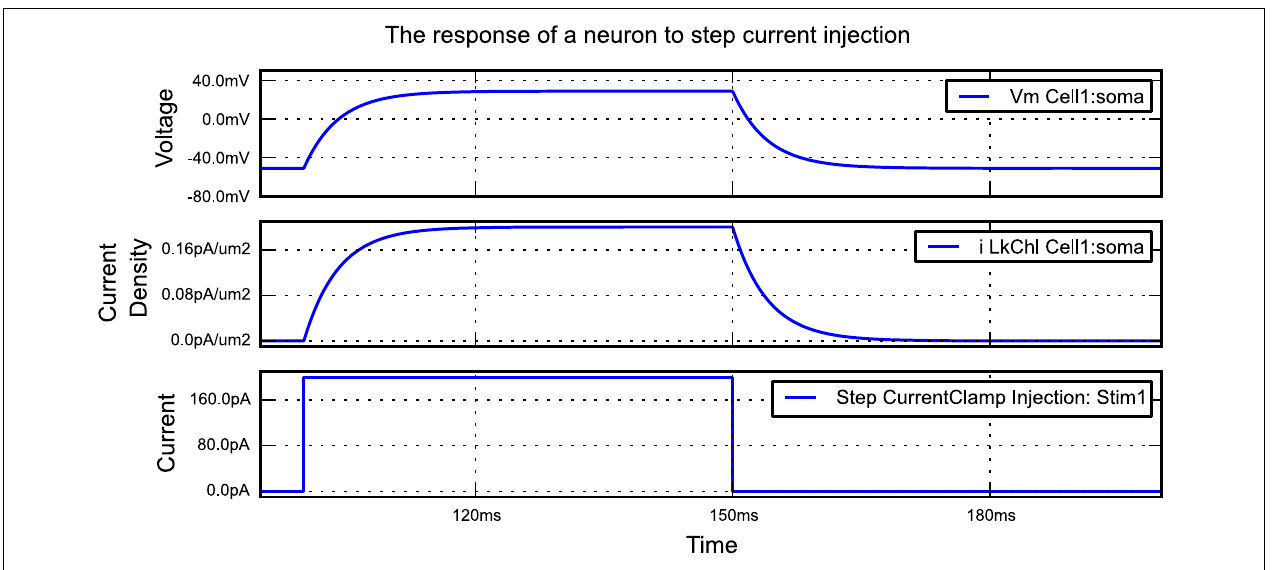
FIGURE 2 | The figure produced by the code in Listing 1. The three recorded variables are automatically plotted on separate axes with corresponding units.